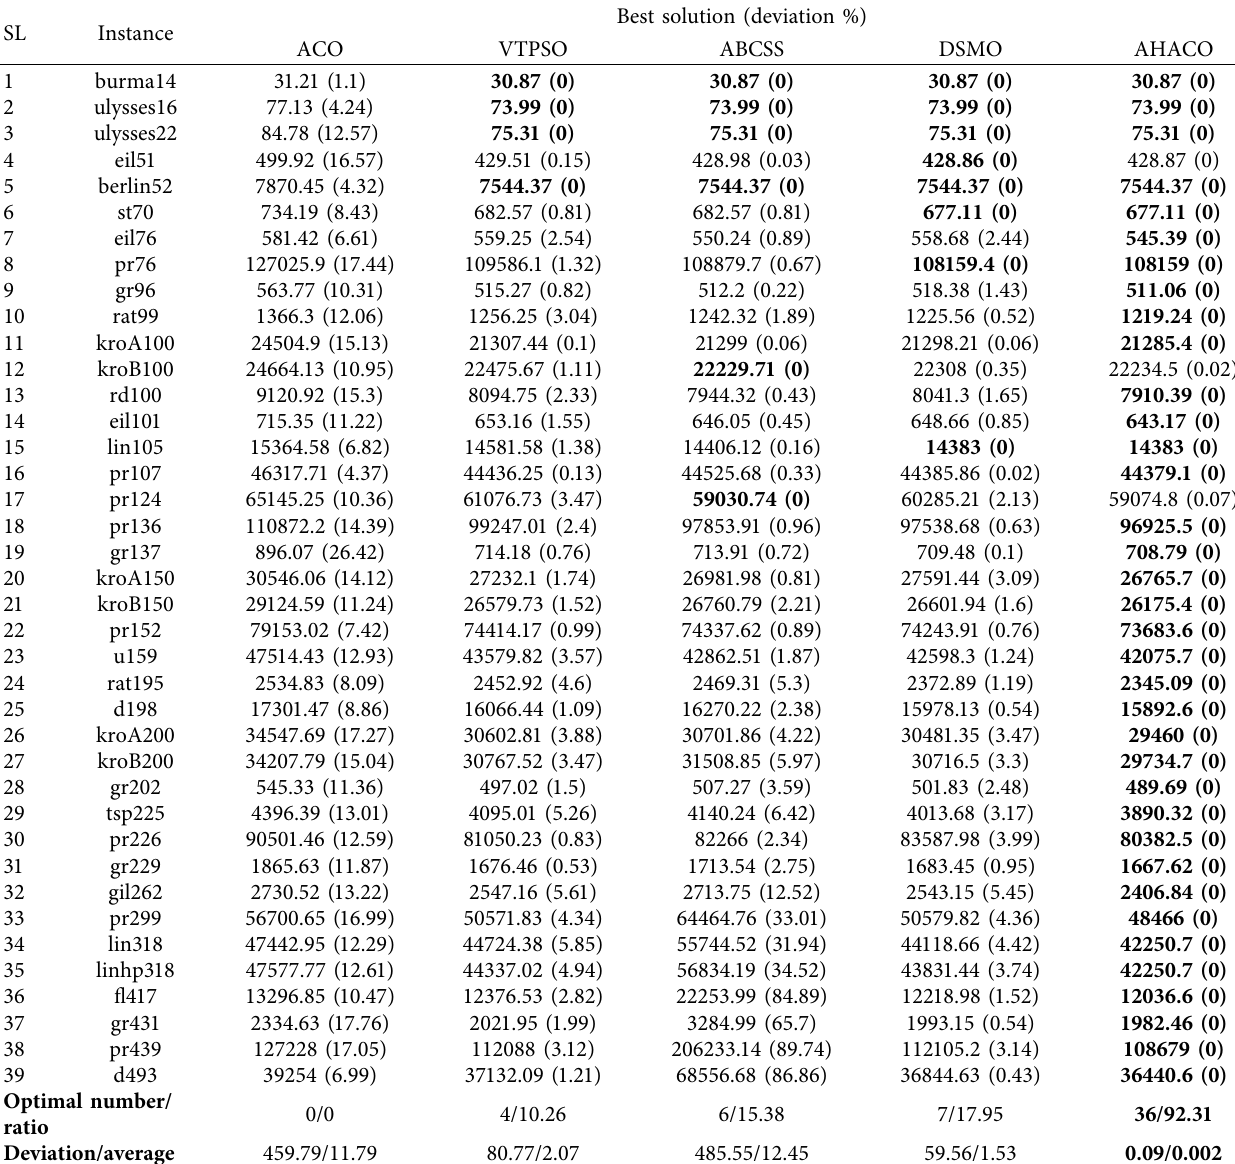
Table 1: Performance comparison among ACO, VTPSO, DSMO, and AHACO on